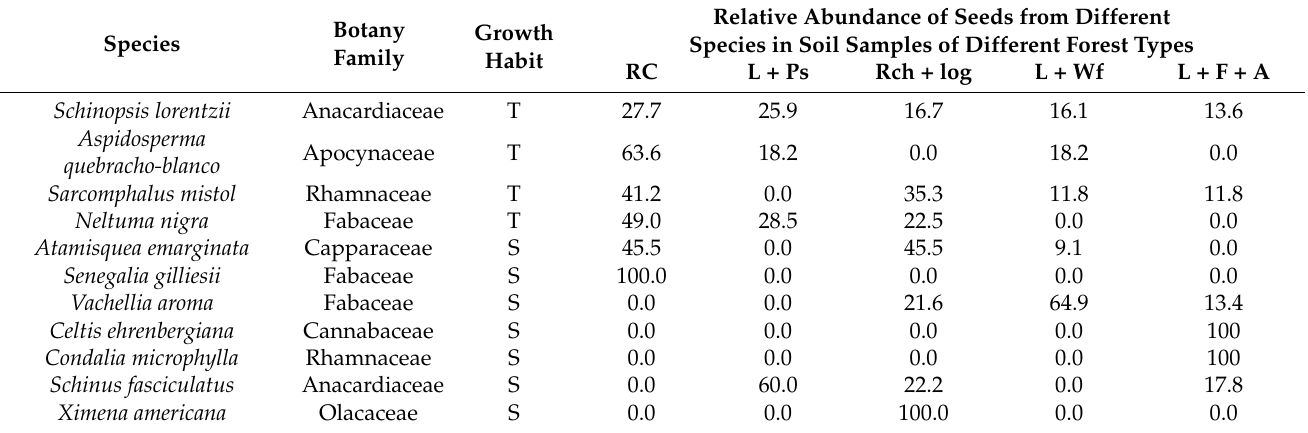
Table 1. Species composition, growth habit, and relative abundance of woody species in soil seed banks from the western-Chaco-region forests, Argentina, with different land-management types. T = tree; S = shrub; RC = reference condition; L+Ps: grazed forest with tropical pasture sowing; Rch+log = rolled- chopping and logged forest; L + WF = grazed and burnt forest; L + F + A = overgrazed, burnt, and abandoned forest.